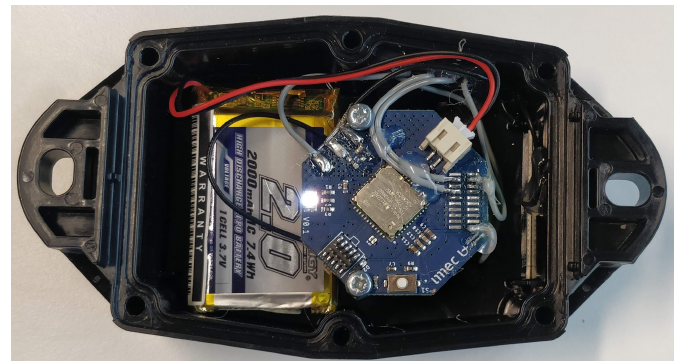
Figure 5. Our multi-RAT LPWAN device is able to switch between Sigfox, LoRaWAN, and DASH7